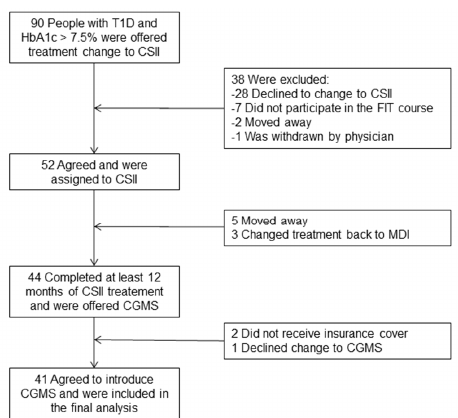
Figure 1. Flow diagram showing the selection of the study population. CSII: Continuous Subcutaneous Insulin Infusion; CGMS: Continuous Glucose Monitoring System; MDI: Multiple Daily Injections; FIT: Functional Insulin Therapy; T1D, type 1 diabetes.